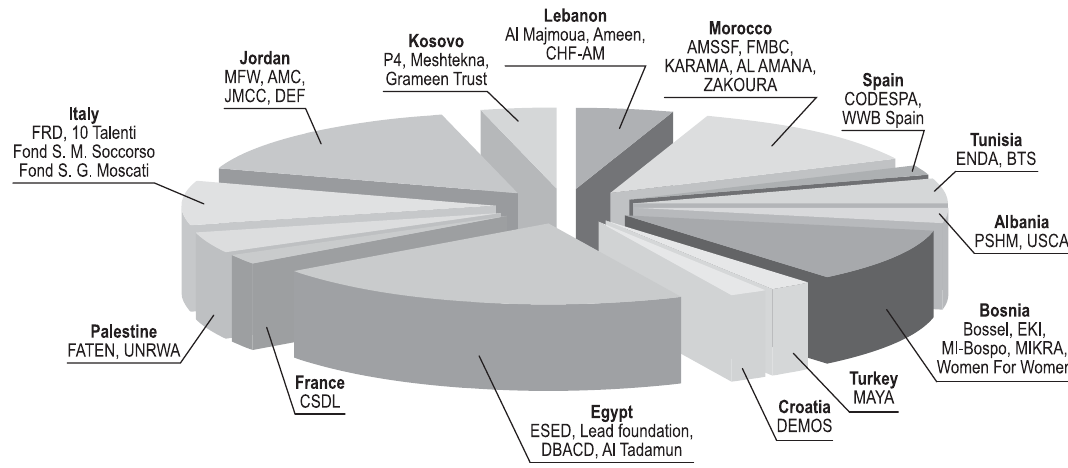
Fig. 1 4 . MFIs delivering microcredit in the